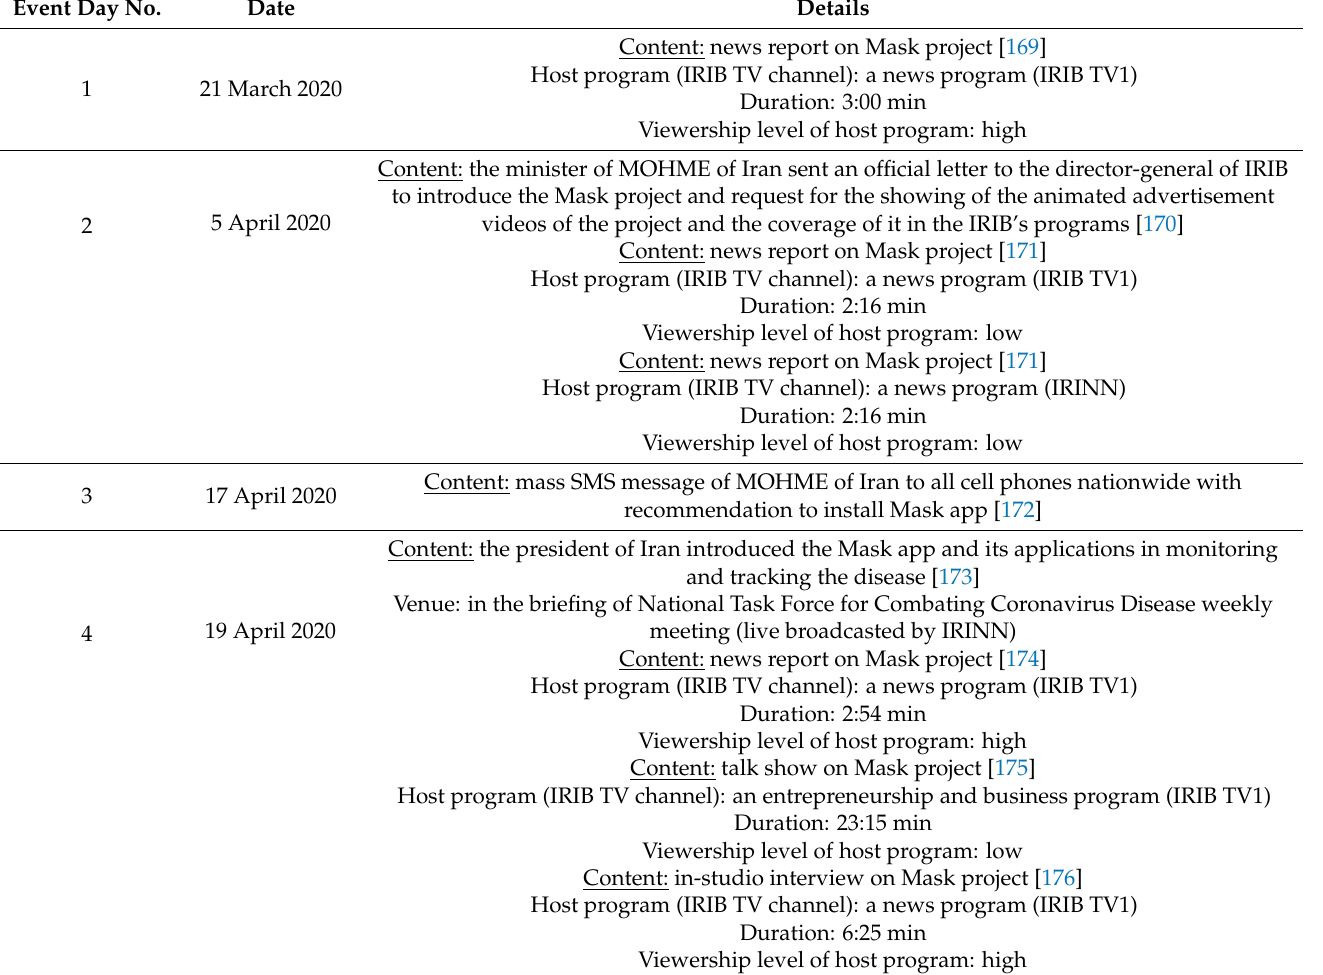
Table 3. The list of identified television programs broadcasted by IRIB related to the Mask project and the endorsement, recommendation, or promotion of the Mask project by the government from 2 March to 30 June 2020. Event Day